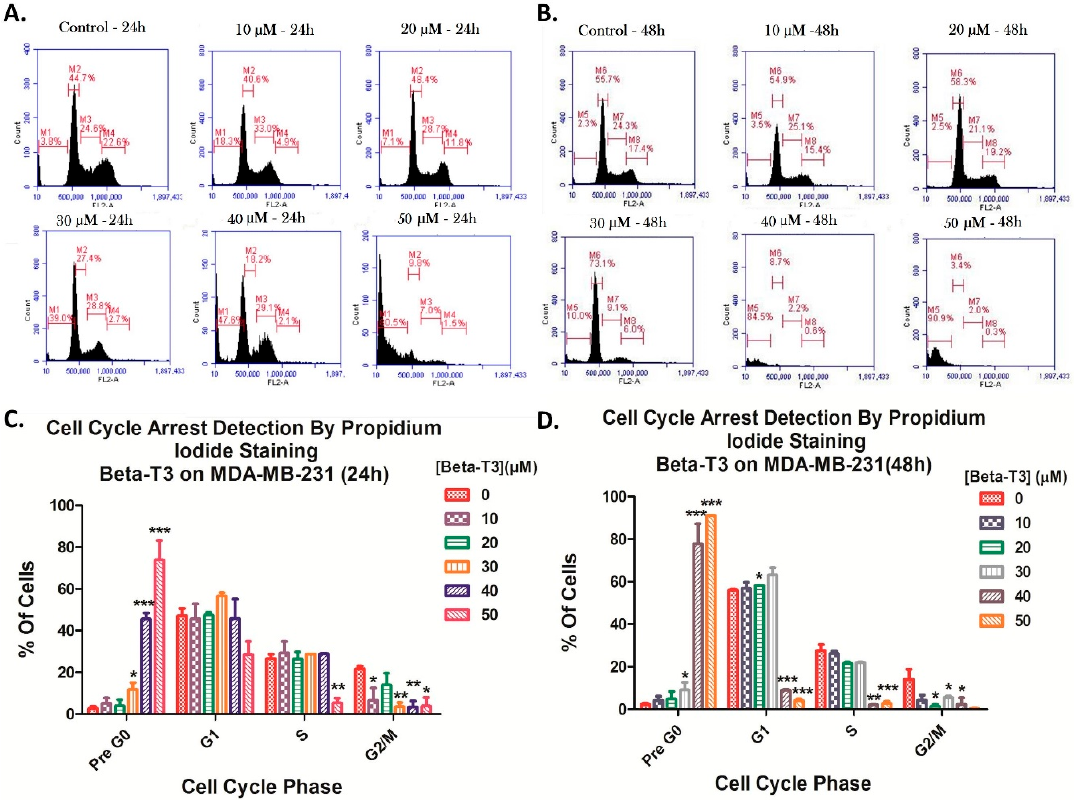
Figure 3. Beta-tocotrienol induced a mild cell cycle arrest of TNBC MDA-MB-231 cells. Cell cycle distribution was assessed by flow cytometry after propidium iodide staining using the range of concentrations: 0–50 µ M for 24 ( A ) or 48 h ( B ). Figures ( A ) and ( B ) were obtained by the C Flow software (version 1.0.227.4, Accuri Cytometers, Ann Arbor, MI, USA). ( C ) and ( D ) represent histograms for analysis of the percentages of cells in each cell cycle phase upon treatment with beta-T3 for 24 and 48 h respectively. *, ** and *** indicate p < 0.05, p < 0.001 and p < 0.0001 respectively.